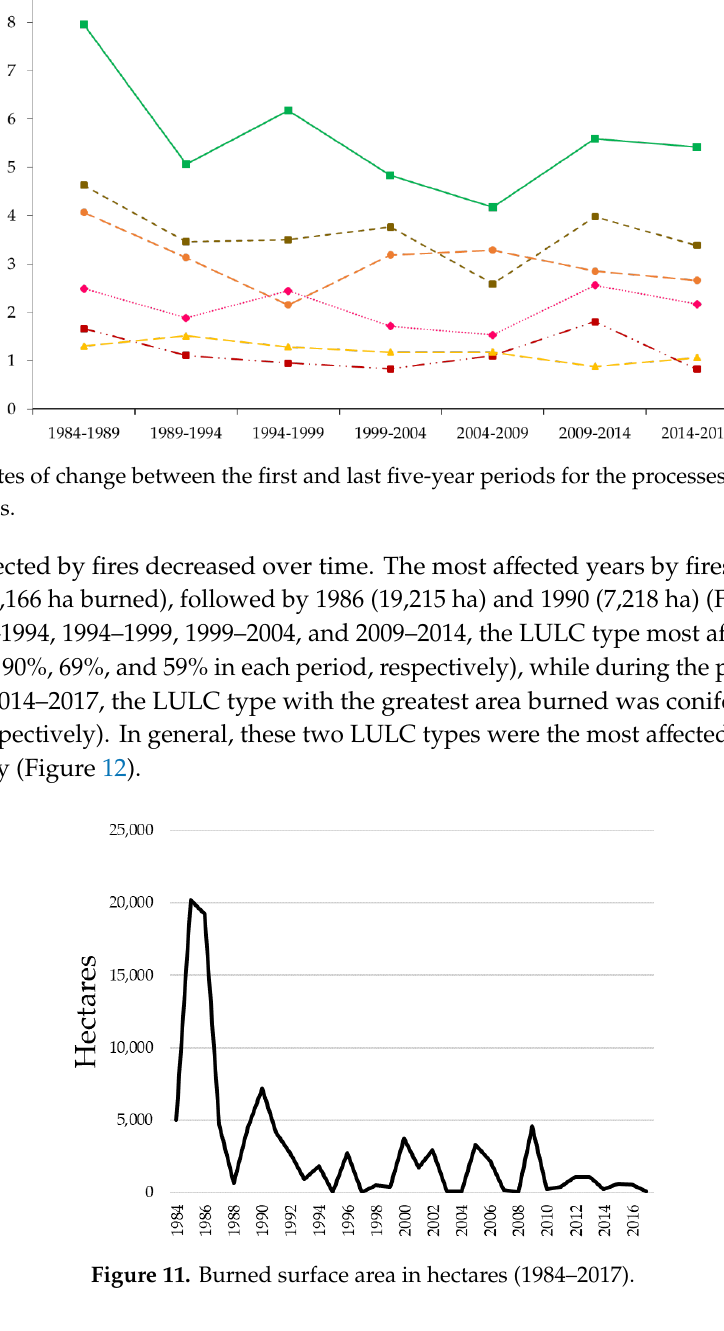
Figure 12. Proportion of LULC types affected by fires for each five-year period from 1984 to 2017. 4. Discussion 4.1. Methodological Issues In order to maximize classification accuracy, input images must have minimal contamination from clouds, haze, or shadows, as these are an important obstacle to studying the ground surface [76]. In this study, we used a simple and robust statistics-based composites method ( “medoid” ) that does not need to set parameters and could be automated for application into very large data collections and time series. In spite of the potential offered by the “medoid” technique, the resulting image collection presented areas without information. This situation underlines the need to complement the analysis with other sensors with similar spectral and spatial characteristics (e.g., Sentinel 2 available from 2015) [29]. Regarding the change analysis, we demonstrate the utility of LT and FT algorithms to detect LULC changes in our study area. However, as with automated algorithms, there are some limitations in their application. For example, FT, in contrast to LT, does not have the ability to generate metrics that are very useful when studying the postdisturbance regeneration, such as year, duration of change, and the spectral values before the change. The LT algorithm, although generating these